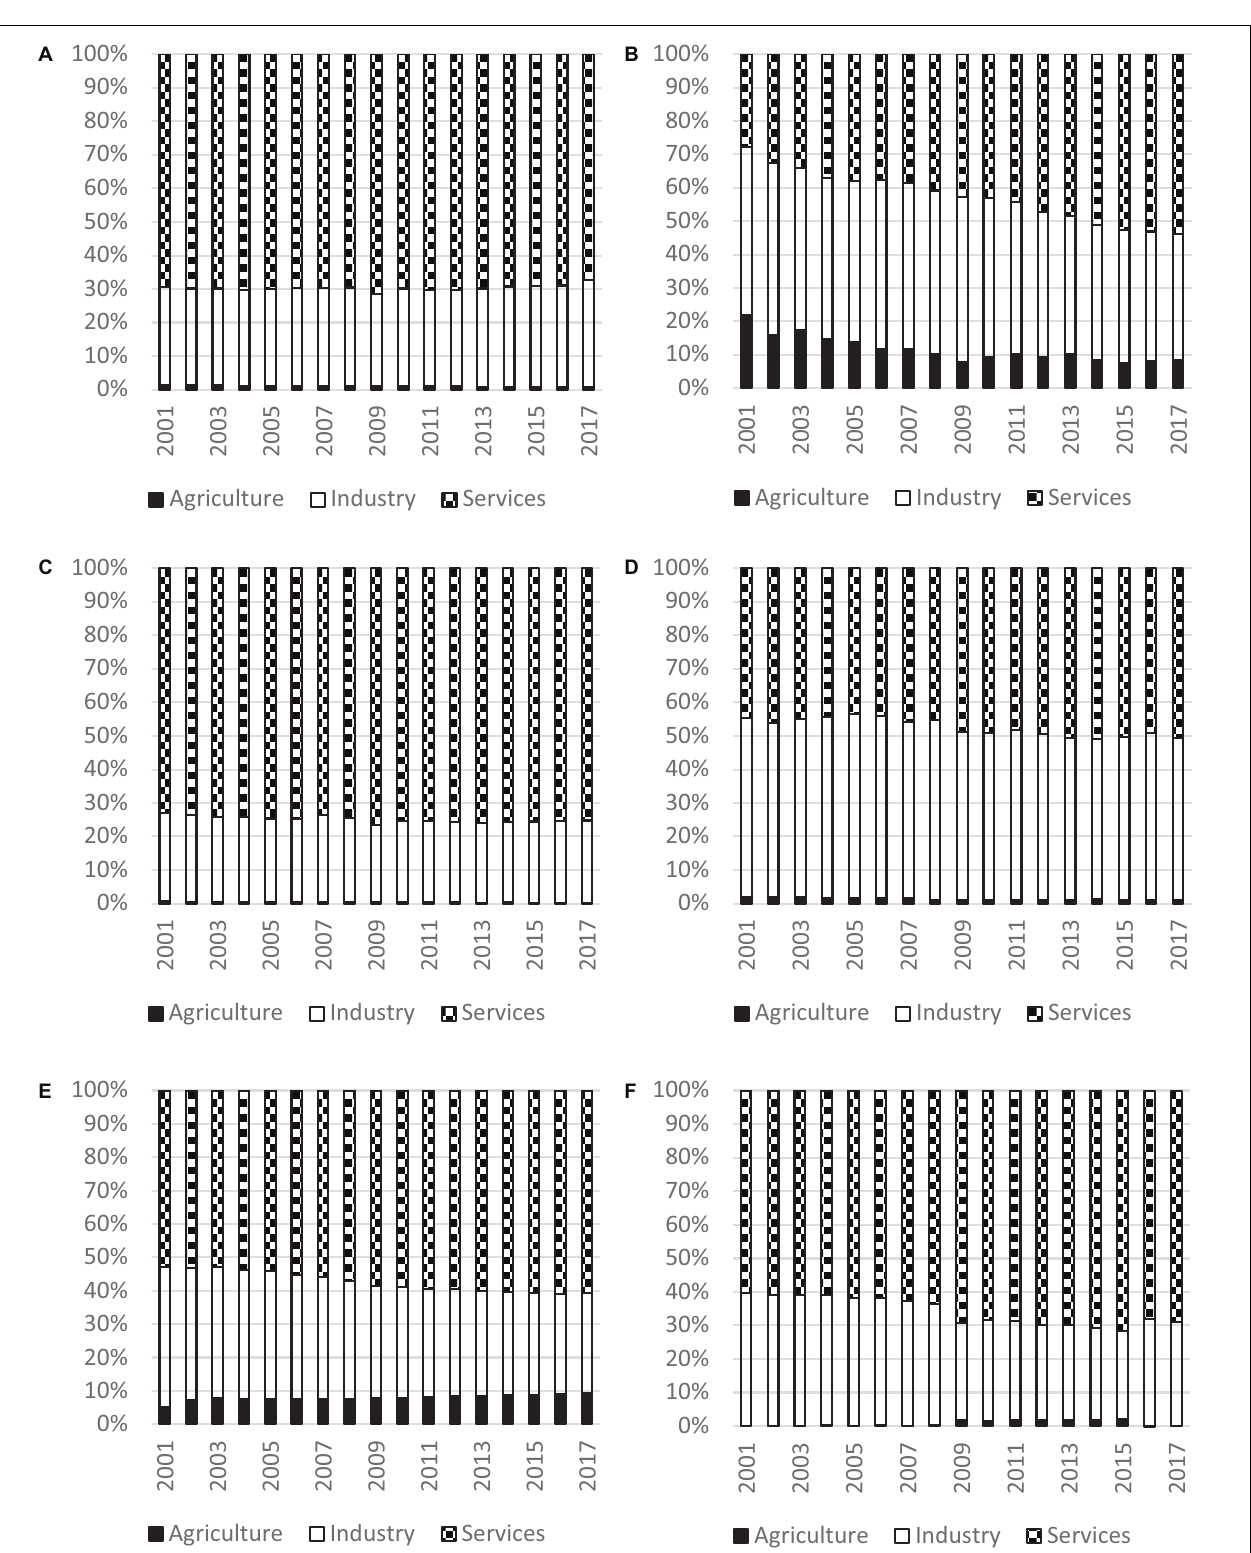
FIGURE 8 | Decomposition of inequality for different regions, 2001 to 2017. Source: Authors’ calculation. (A) East Asia and Pacific, (B) South Asia, (C) Europe and Central Asia, (D) Middle East and North Africa, (E) Sub-Saharan Africa, and (F) Latin America and Caribbean.